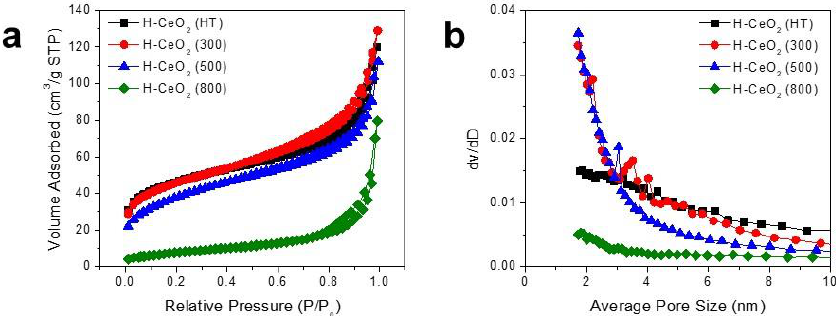
Figure 2. ( a ) Nitrogen isotherms and ( b ) BJH pore size distributions of the H-CeO 2